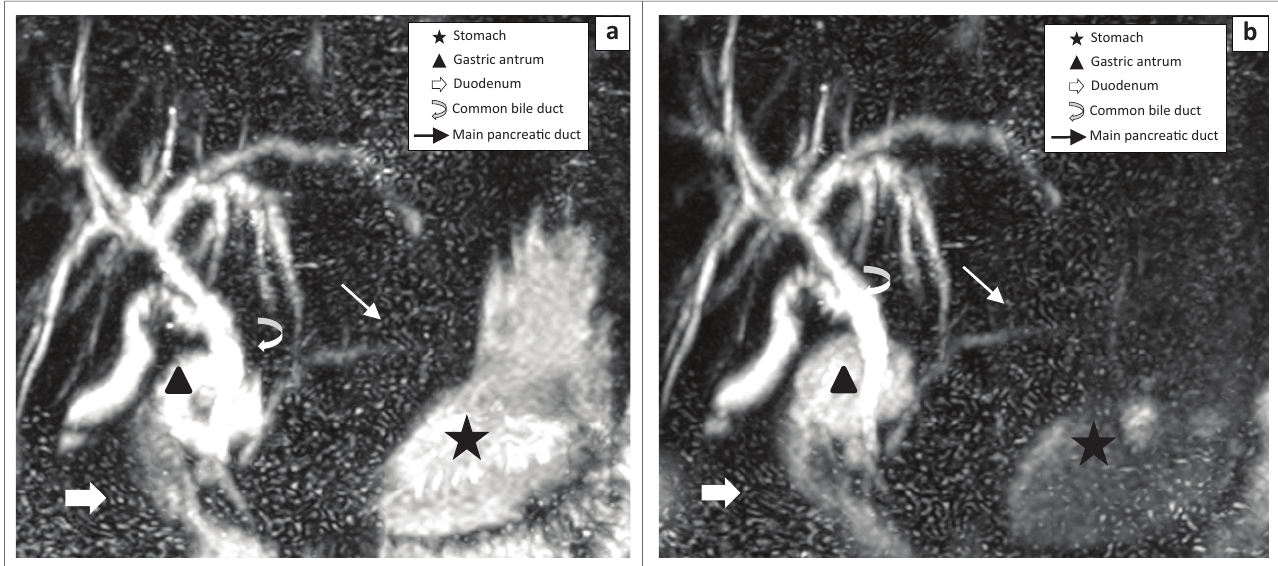
FIGURE 1: This maximum intensity projection coronal reconstruction magnetic resonance cholangiopancreatography image demonstrates a significant reduction in signal intensity of the stomach from moderate to slight signal intensity ( Δ maximum ROI from 1883.5 to 1020): (a) pre-contrast magnetic resonance cholangiopancreatography; (b) post-contrast magnetic resonance cholangiopancreatography. Correspondingly, visualisation of the common bile duct (CBD) improved from good to excellent. This is explained by reduction in signal in the gastric antrum resulting in improved visualisation of the overlapping CBD. The duodenum had no subjective improvement with moderate signal intensity in both pre- and post-contrast imaging ( Δ maximum ROI 2145 → 1897). The main pancreatic duct (MPD) remained visible with some